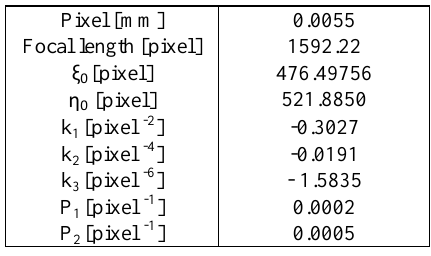
Table 5 Calibration parameters fixed during the Photoscan process